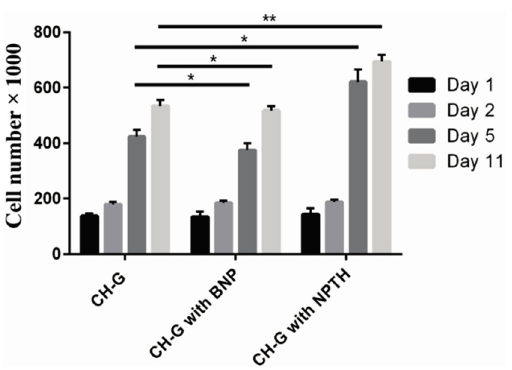
Figure 11. Metabolic cell viability of hFOB cells on scaffolds engrafted with various amounts of microparticles; day 1, 2, 5 and 11 post seeding of cells on scaffolds. Bars represent the average cell number and error bars indicate standard deviation, * , p < 0.05 and ** , p < 0.0001.